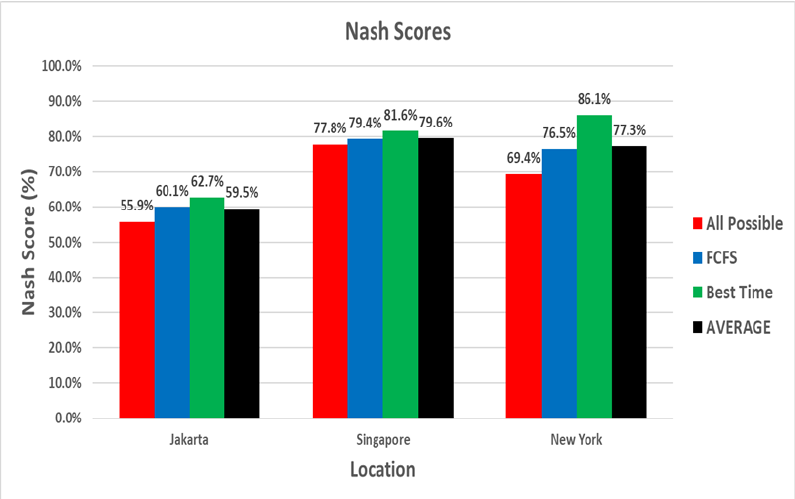
Figure 9. Ridesharing Nash Score